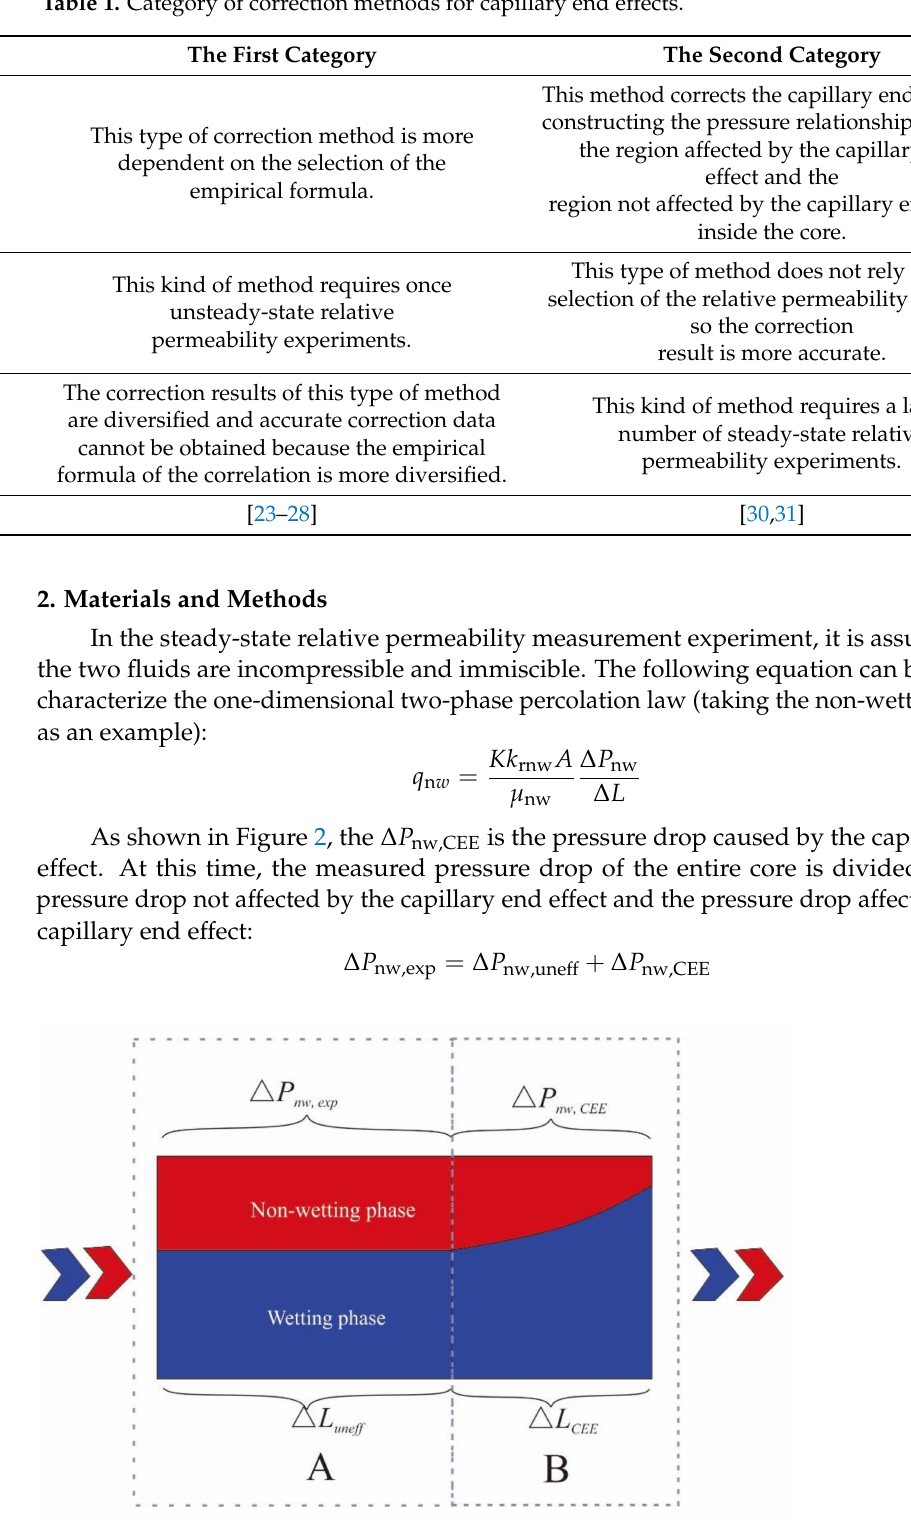
Figure 2. Diagram of the internal conditions of the core (according to whether it is affected by the capillary end effect, the core is divided into two regions: A and B. The fluid in the core is divided into a wetting phase (blue) and a non-wetting phase